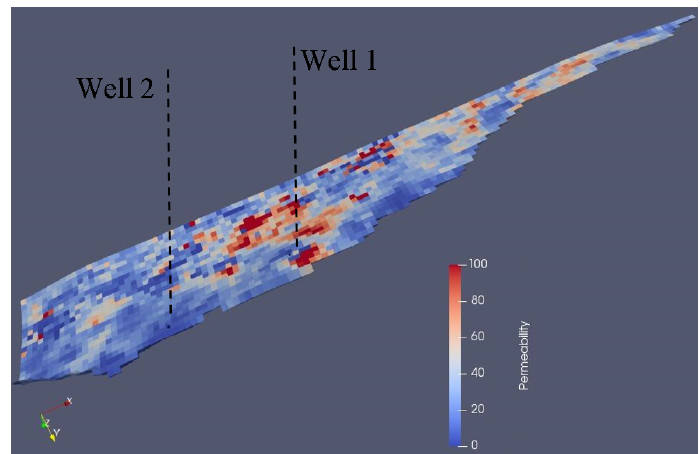
Figure 17. Field permeability